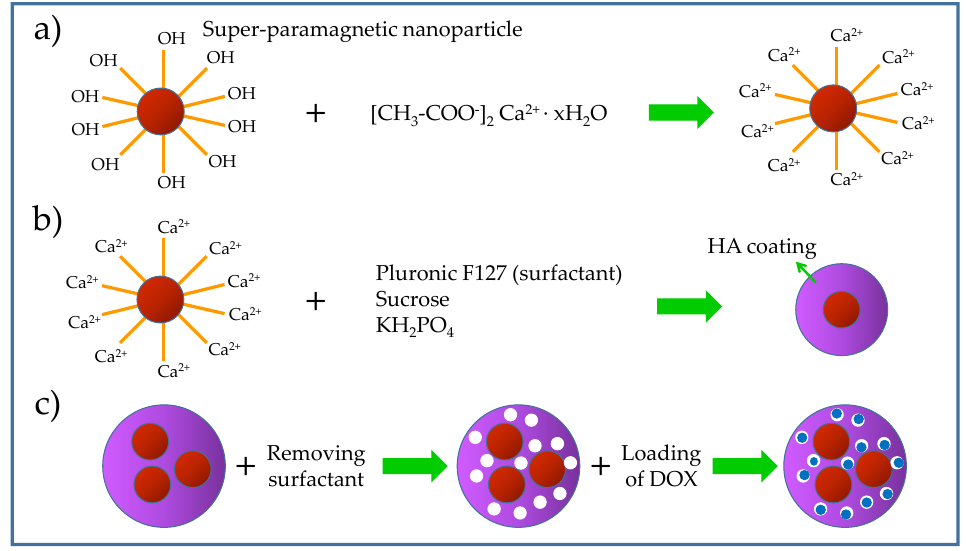
Figure 7. Scheme showing the synthesis of super paramagnetic mesoporous HAp nanoparticles as a carrier for DOX. ( a ) SPION conjugation for the formation of super paramagnetic Hap; ( b ) Formation of a mesoporous HAp with nanometer pores in combination with SPIONs as a core; ( c ) DOX molecules loaded into the magnetic nanoparticles coated with mesoporous HAp by a diffusion process. Adapted from [105], Elsevier,